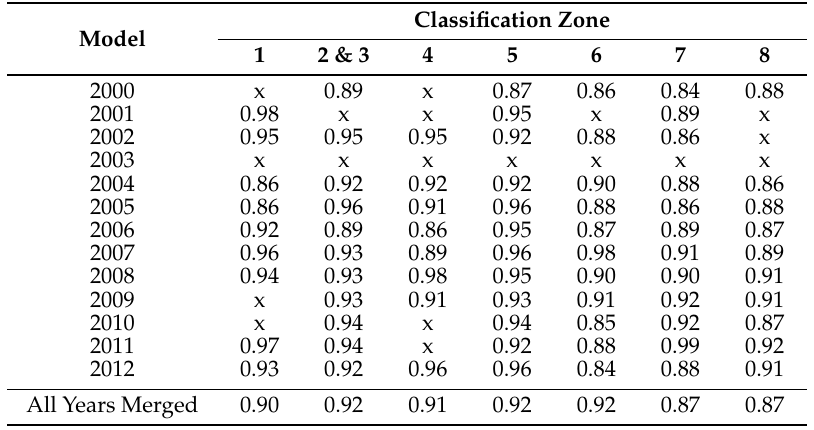
Table 4. OAs of CVP classifications (summer crop, winter crop, bare land, double crop, perennial & fodder crop, low natural vegetation) using RF models (the situation that multi-annual RF outperformed annual RF models are grey-shaded); and all validation samples of all available years with the multi-annual RF model. ‘x’ = no reference Landsat data available within this classification zone and year.